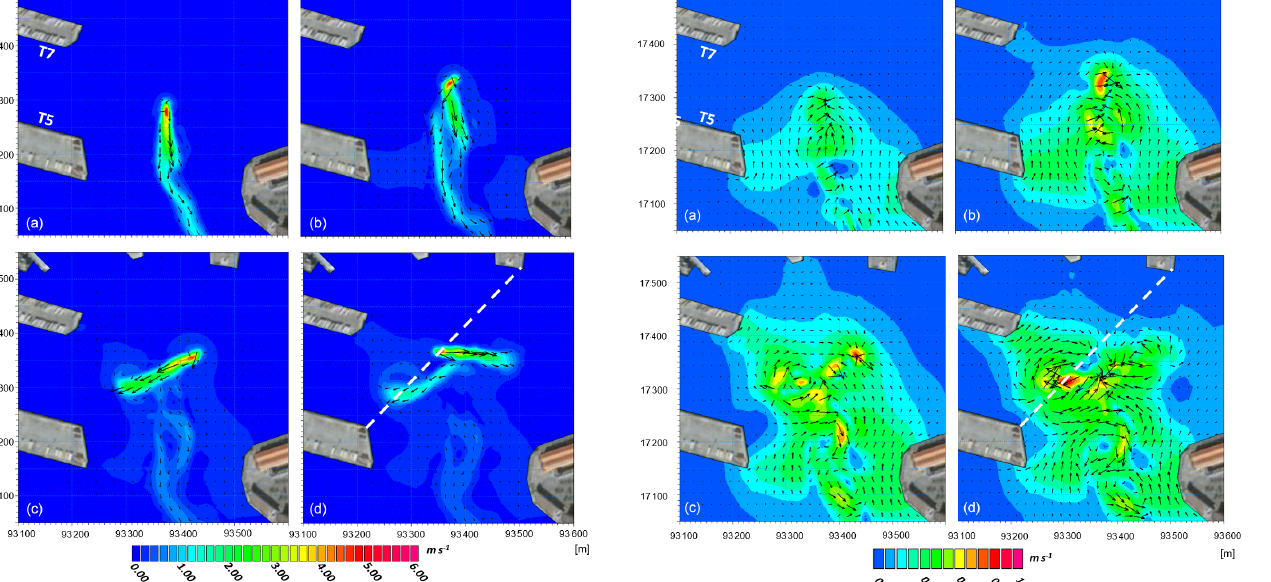
Figure 9. Results of the hydrodynamic model in the bottom layer. Each panel refers to a time interval of approximately 100s from the previous panel. The temporal order of the panels is as follows: (a) , (b) , (c) , and (d) . The images refer to docking maneuvers of the Ro-Ro vessel representative of dock T7. Land background from © Google